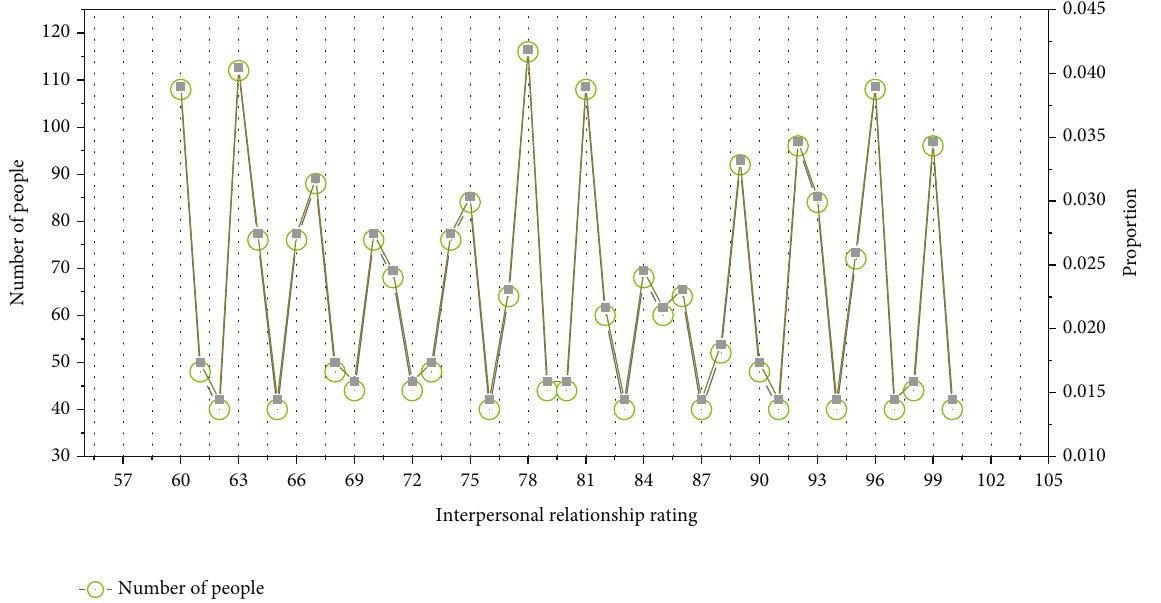
Figure 3: Statistics of people with di ff erent ratings of interpersonal